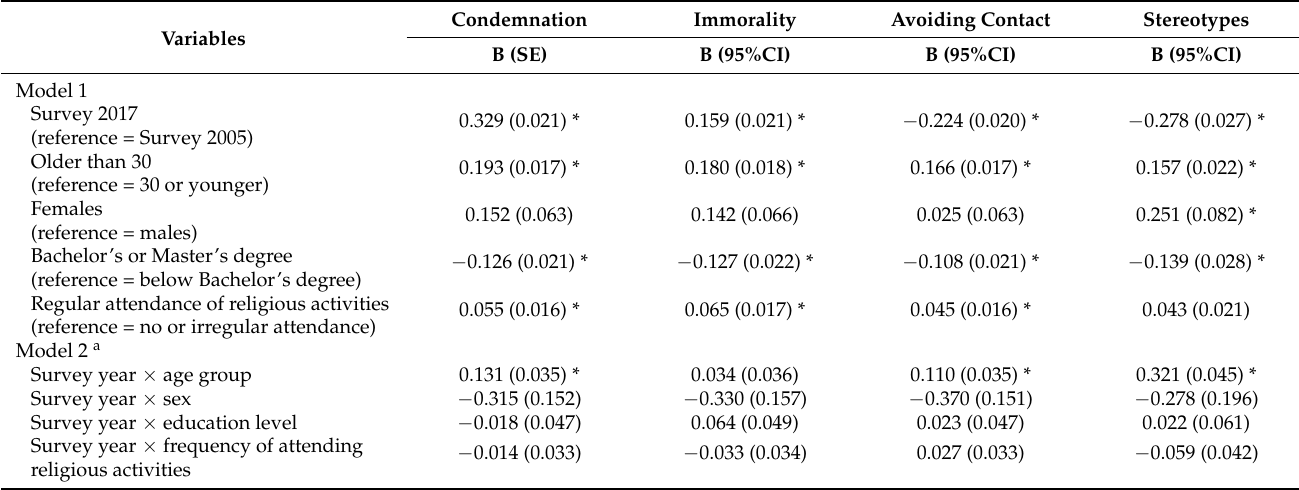
Table 2. Factors related to attitudes toward homosexuality: multiple regression